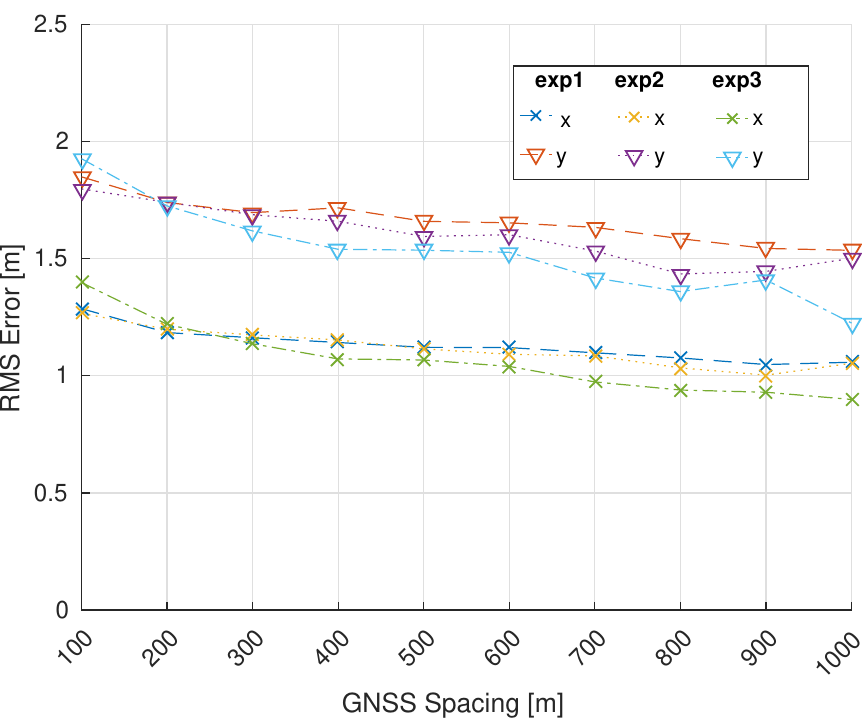
Figure 3. Ice-relative x − y vehicle position RMS error averaged over the 7.7 km simulated mission, plotted as a function of GNSS spacing for exp1, exp2, and exp3. Increasing separation between GNSS units is correlated with decreasing ice-relative vehicle position error.